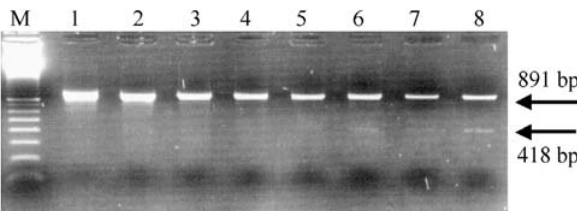
Figure 4 - GH genomic and cDNA amplicons separated in 1.5% agarose gel electrophoresis. Lane M: 100-bp DNA molecular weight markers;